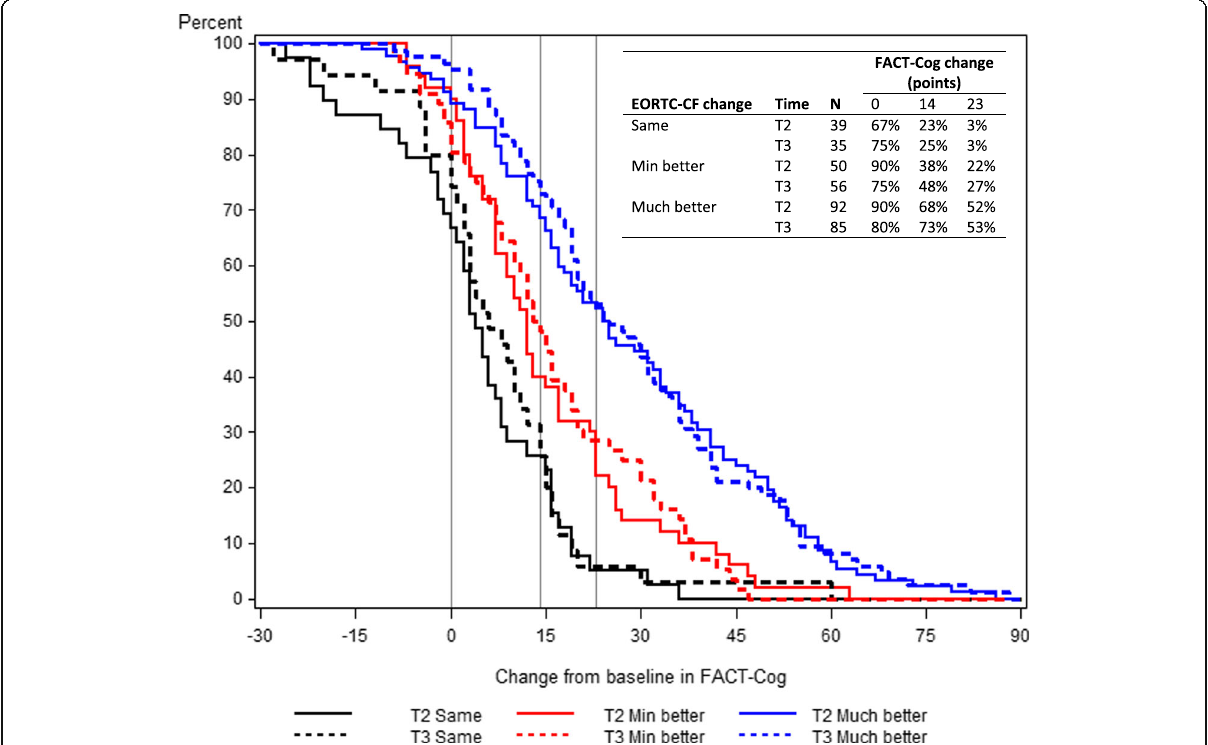
Fig. 1 Empirical cumulative distribution functions of change from baseline in the FACT-Cog, stratified by categorized anchor change (EORTC-CF) and time (T2 = post intervention, T3 = 6 months). Larger values of change are better. Possible meaningful change thresholds of 14 (SEM) and 23 points (difference between “ much better ” and “ same ” ) are shown as vertical lines, as well as change of 0. The table gives percentages of participants who changed by at least a given